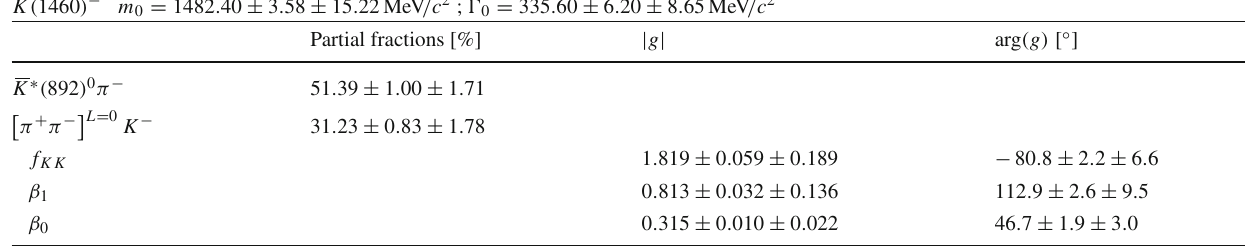
Table 5 Table of fit fractions and coupling parameters for the compo- nent involving the K ( 1460 ) − meson, from the fit performed on the RS decay D 0 → K − π + π + π − . The coupling parameters are defined with